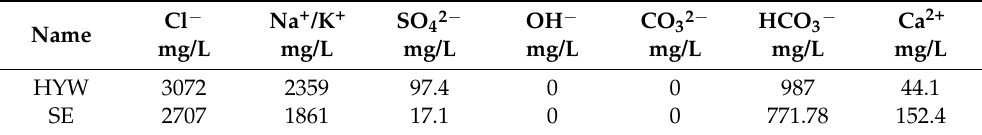
Table 4. Ion analysis of water contained in HYW and SE